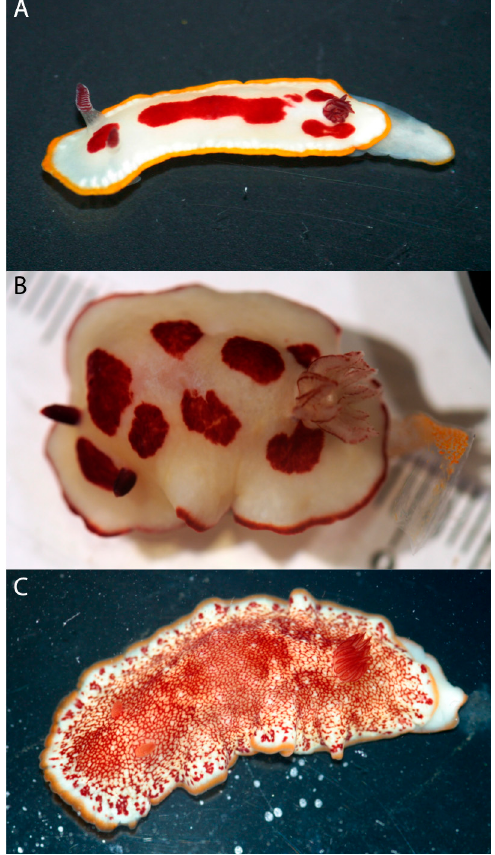
Figure 1. Images of Goniobranchus species under study. ( A ) G. splendidus from Mooloolaba, Queensland (QLD); ( B ) tropical specimen of G. cf. splendidus collected from near Mackay, QLD; ( C ) G. tinctorius from Stradbroke Island.